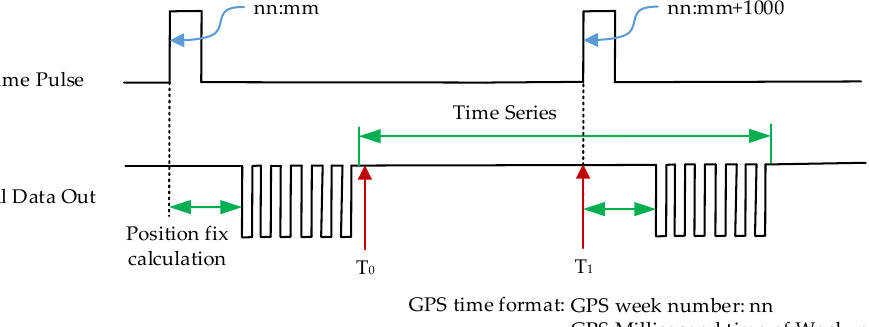
Figure 10. The 1-s time series of GPS time.